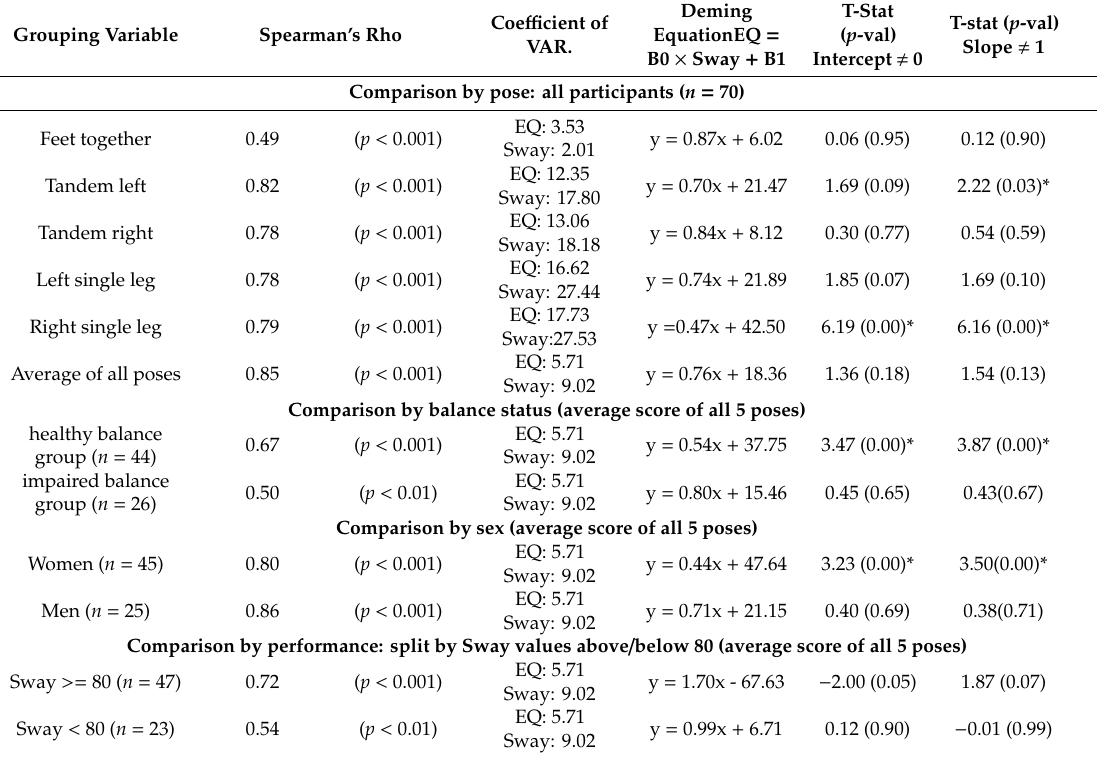
Table 2. Method comparison summary—Spearman’s correlation and Deming regression.